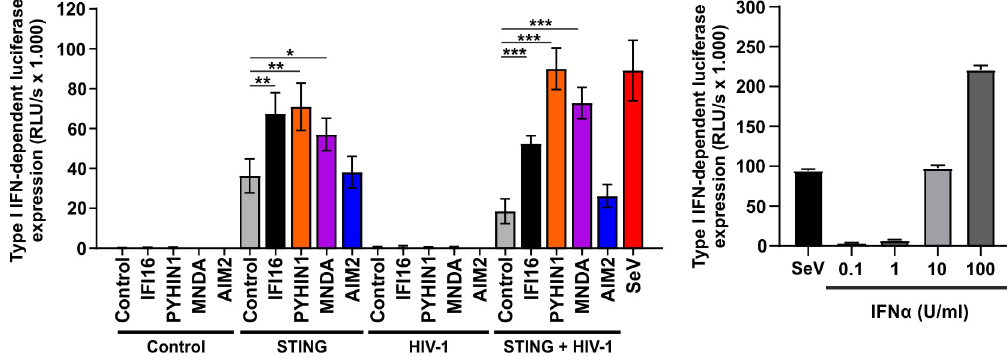
Fig 2. Human PYHIN proteins do not induce IFN in HEK293T cells lacking STING. HEK293T cells were transfected with the indicated PYHIN protein and/or STING expression vectors and the proviral HIV-1 NL4-3 IRES-eGFP construct, or infected with Sendai virus (SeV). 40 hours later, supernatants were harvested and used to stimulate HL116 IFN-reporter cells in triplicates. After 8 hours, luciferase expression in the HL116 cells was determined. Shown are mean values from three independent experiments ± SD. P-values indicate differences between IFN production detected in the presence and absence of the indicated PYHIN proteins; � p < 0.05, �� p < 0.01, ��� p < 0.001. The right panel shows an IFN α standard curve for